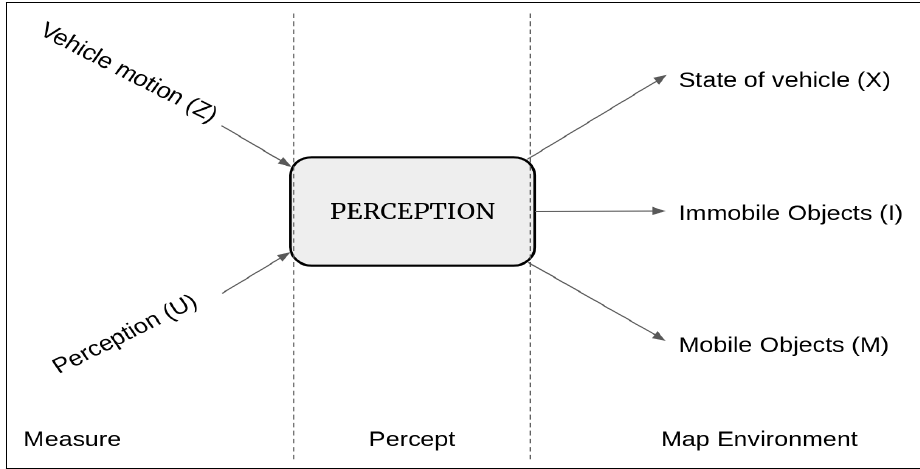
Figure 2. Concepts of